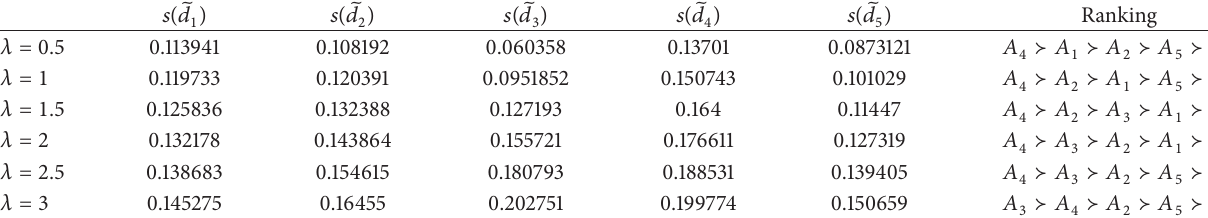
Table 2: Scores of the dual hesitant fuzzy values obtained by GDHFCOA operator.